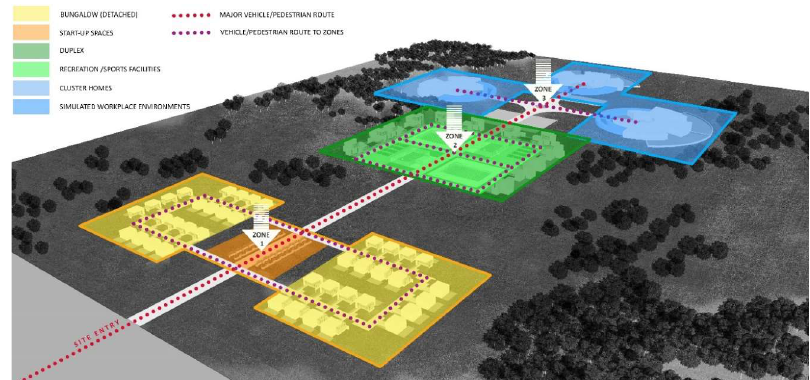
Figure 2. Proposed zoning of the autism